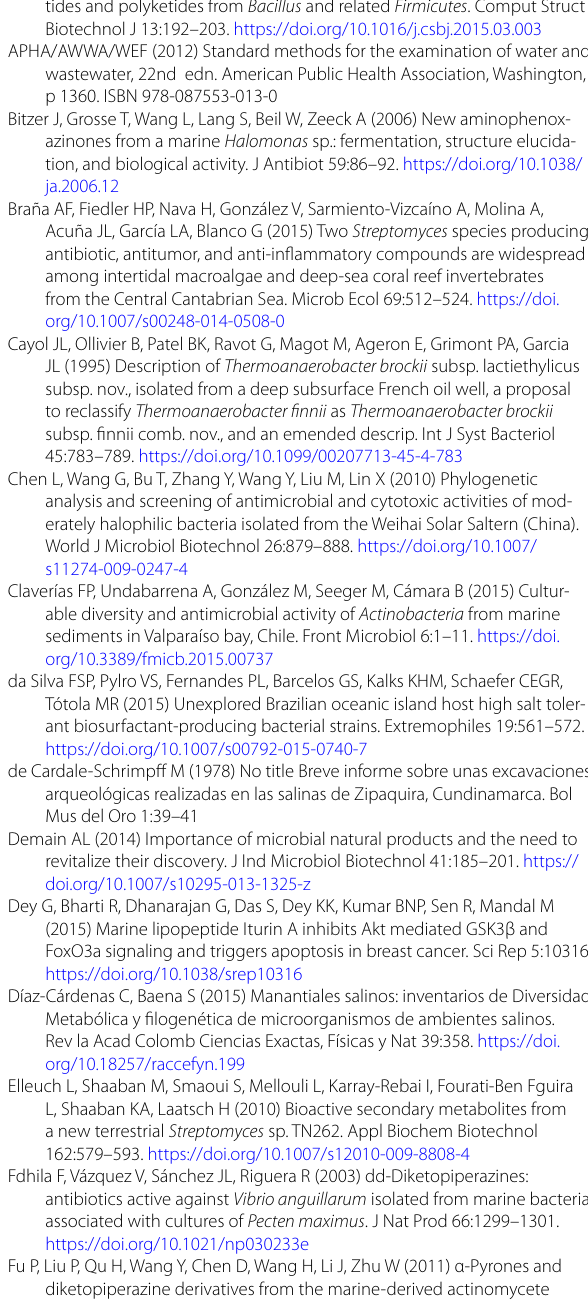
Additional file 1: Table S1. Cultures conditions for cytotoxic activity screening assays. Table S2. Physicochemical characteristics of sampling sites in the salt mine in